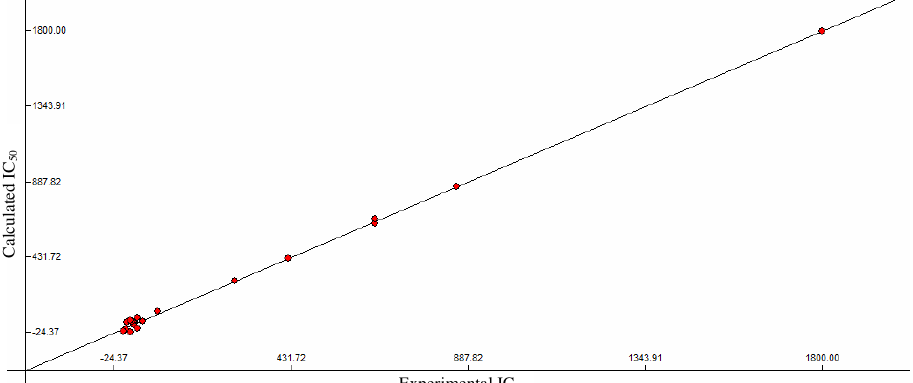
Figure 2. Comparison of experimental and calculated biological activity from the regressional analysis in eq. (5). R 2 = 0.9981; R 2 = 0.9970; F=1388.89; s 2 = 540.03 for 19 cv organosulfurs Table 3. Inter-correlation matrix of descriptors involved in the obtained QSAR model in eq. 4